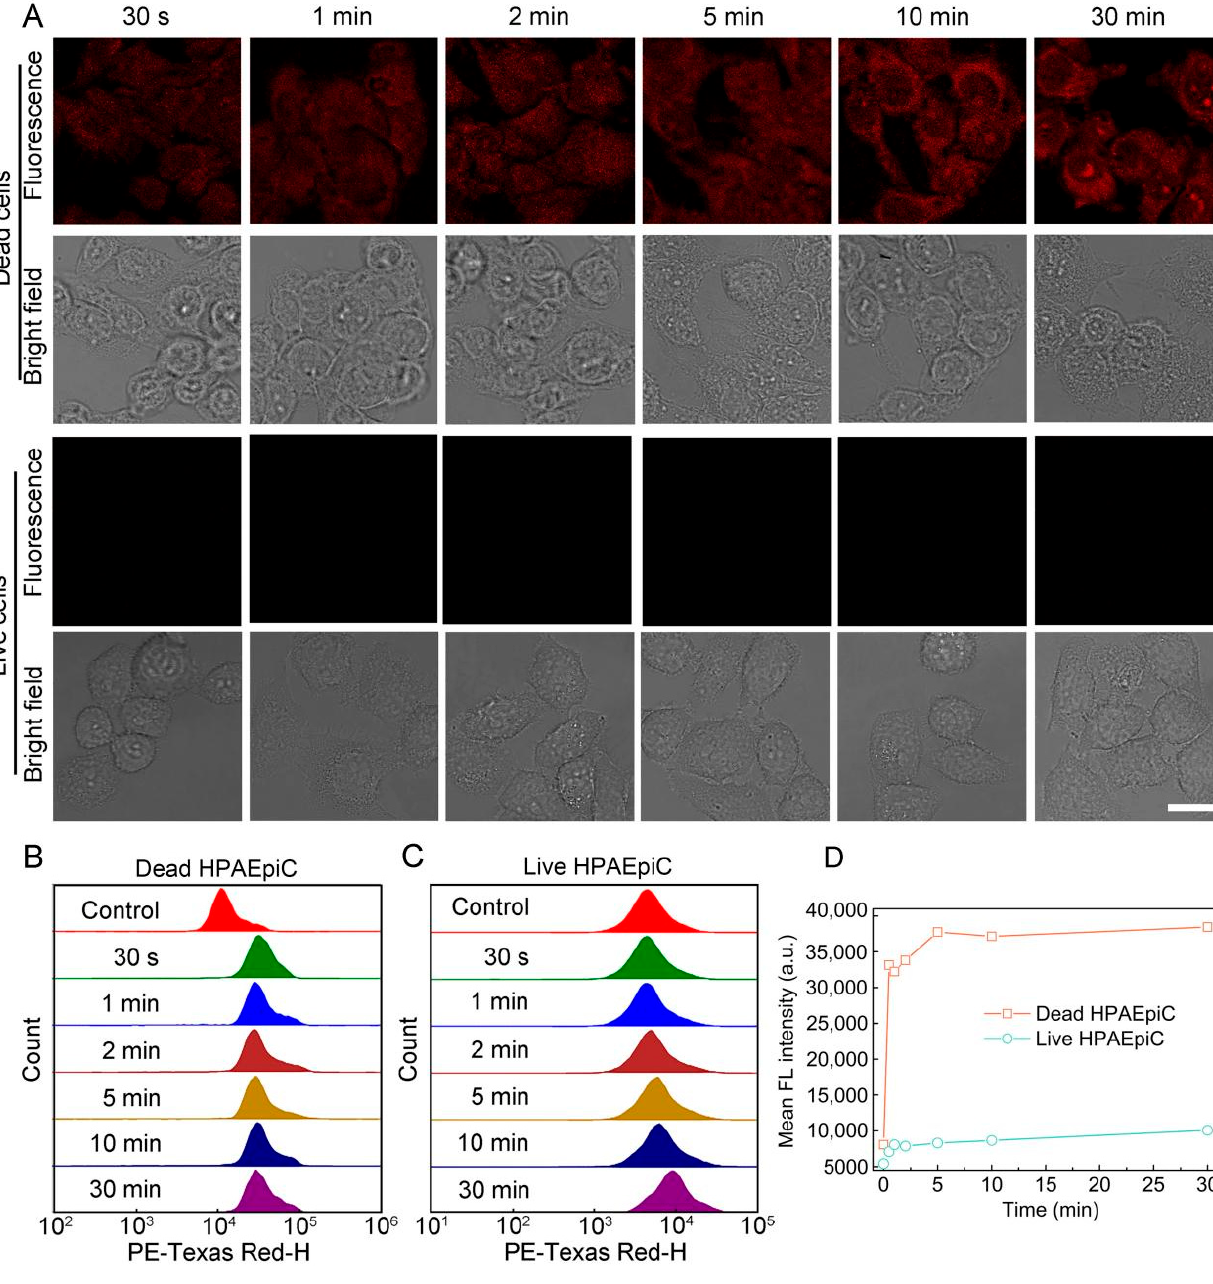
Figure 9. ( A ) Confocal images of dead and live HPAEpiCs treated with S-OSiNDs (5 µ g/mL) for different time periods. Scale bar = 25 µ m. Flow cytometric results of dead ( B ) and live ( C ) HPAEpiCs incubated without (control) or with S-OSiNDs (5 µ g/mL) for different time periods and ( D ) corre- sponding quantitative mean fluorescence intensities derived from the flow cytometric results.